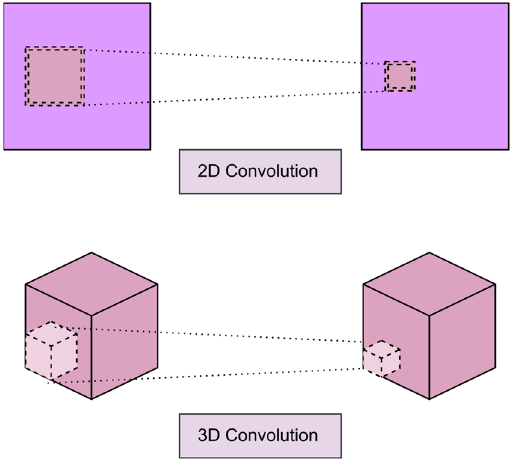
Figure 5. 2D vs. 3D convolution layer.